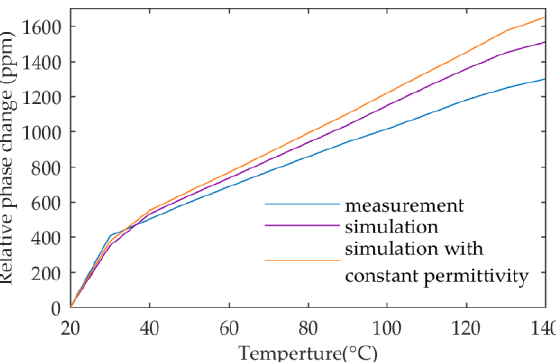
Figure 9. Thermal phase stability of the corrugated phase stable cable obtained by multi-physics